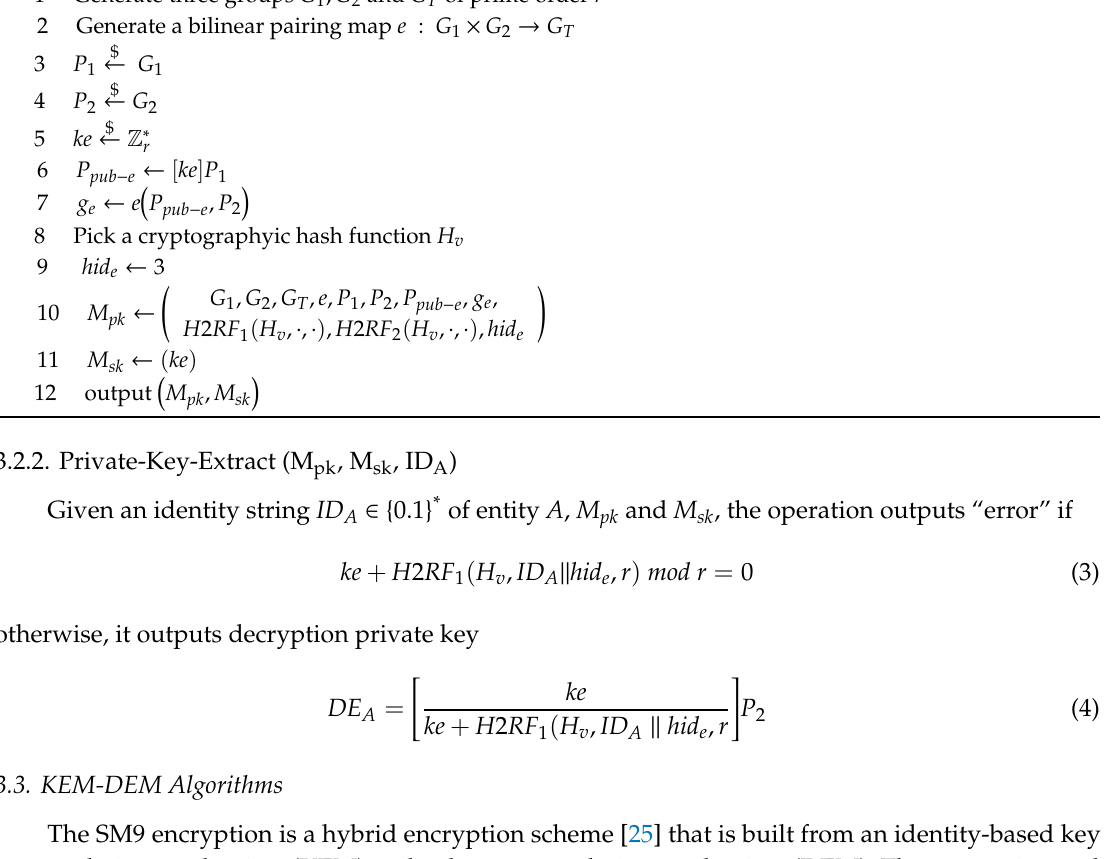
Algorithm 4 Setup